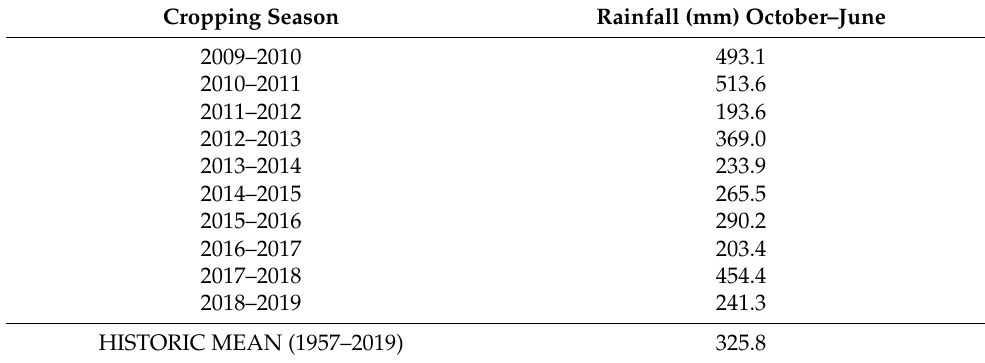
Table 3. Accumulated rainfall (mm) during the cropping season (from October to June) and the historic mean value (1957–2019). Data were collected from the meteorological station located close to the field experiment in La Canaleja